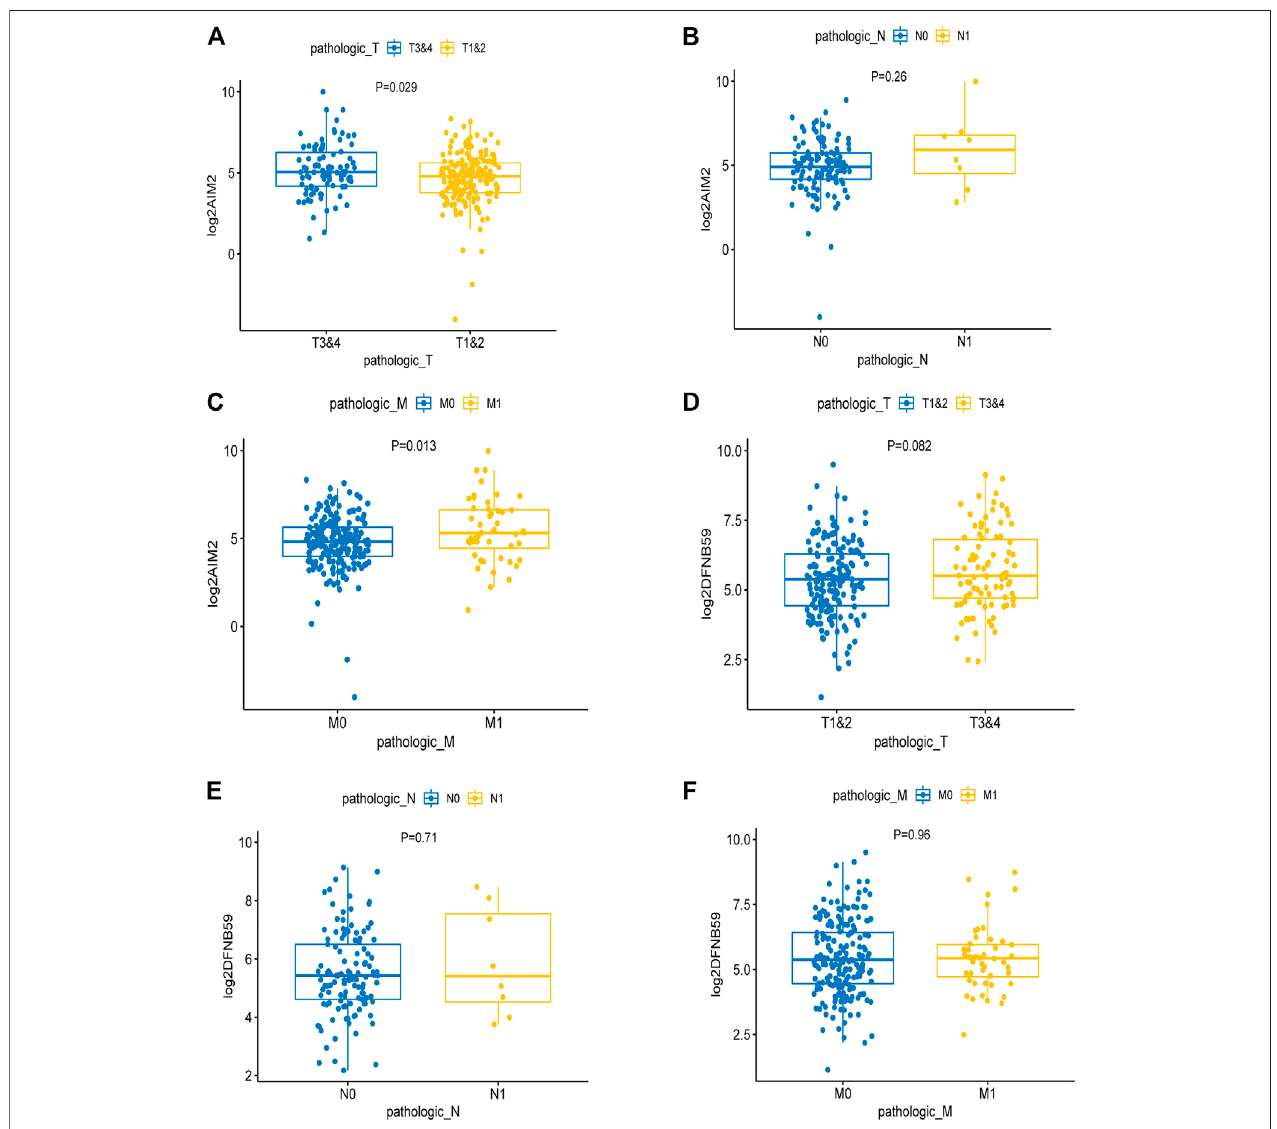
FIGURE 3 | The effect of the expression of independent PAGs on tumor progression. (A,C) The expression of AIM2 in the advanced T and M1 stages was higher than that in the early T and M0 stages. (B) There was no difference in the expression of AIM2 in different N stage. (D – F) The expression of DFNB59 in different TNM stages, with no statistical signi fi